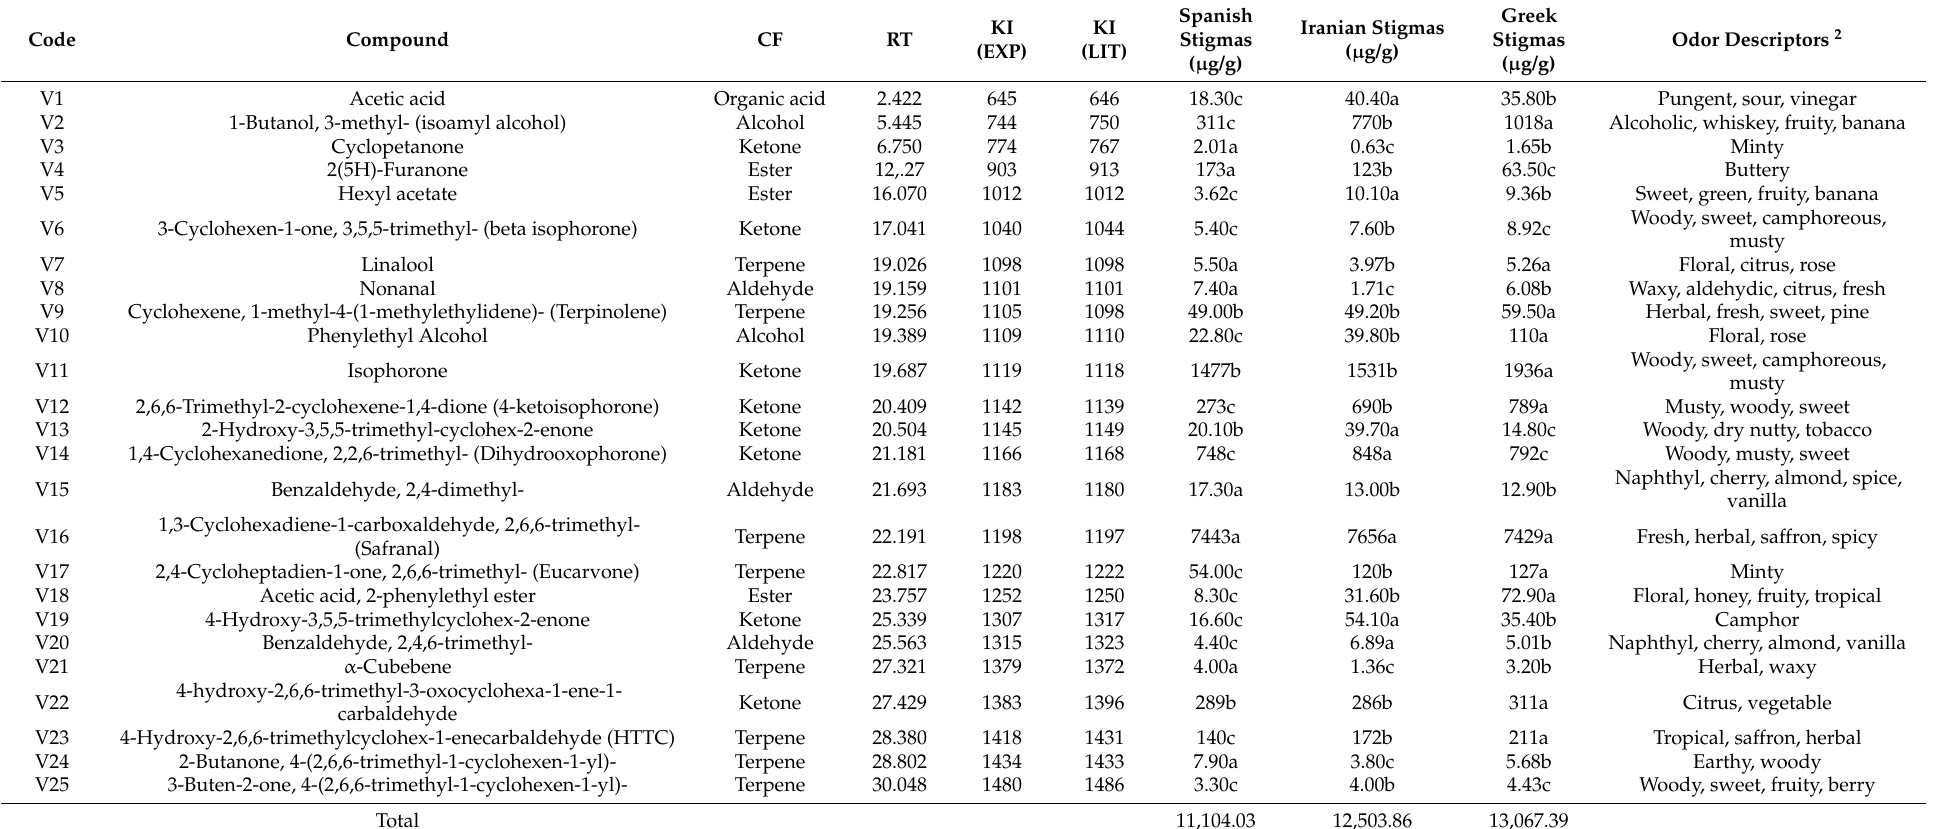
Table 4. Identification, concentration ( µ g/g) and descriptors of volatile compounds found in saffron stigmas 1